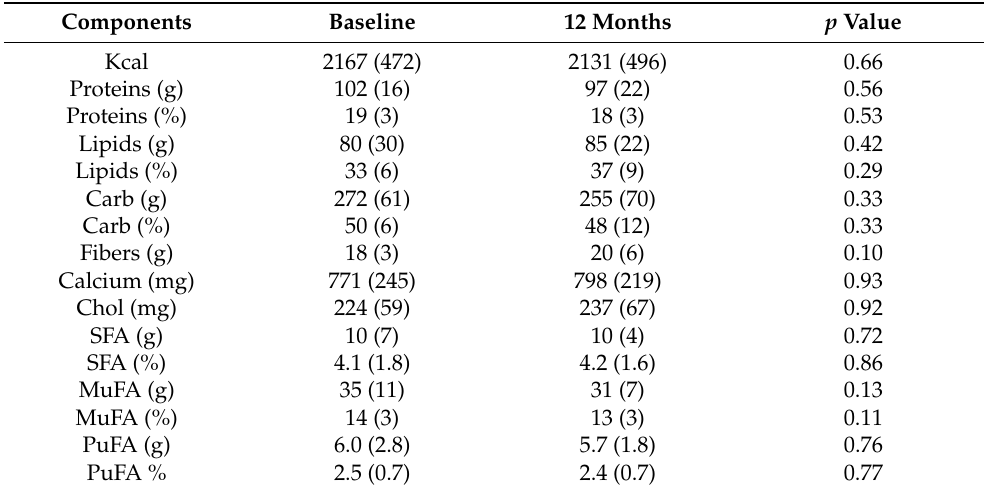
Table 4. Comparison between the nutritional data at baseline and 12 months ( n = 11). Data are reported as mean (SD). Abbreviations: Carbohydrates (Carb), Cholesterol (Chol), Saturated fatty acid (SFA), Monounsaturated fatty acids (MuFA), Polyunsaturated fatty acids